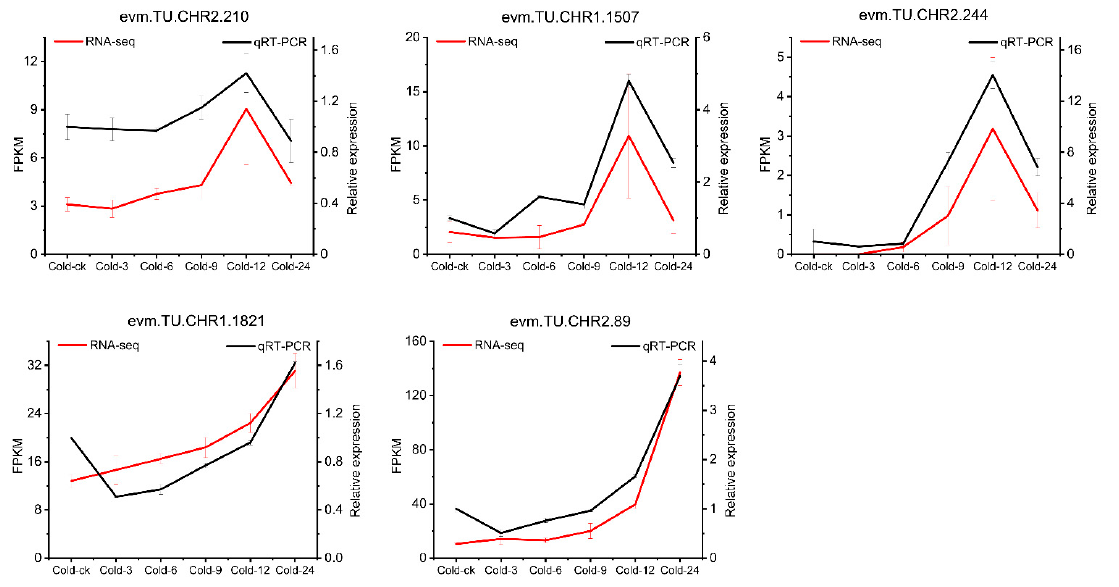
Figure 9. The expression analysis of five genes from the I. dabieshanensis core cold stress responsive genes. The relative expression of five genes was obtained by qRT-PCR based on 2 −∆∆ Ct method [46], while FPKM values of five genes were obtained by RNA-Seq. Data are from three biological replicates and three technical replicates. Results are the means ± standard error of the